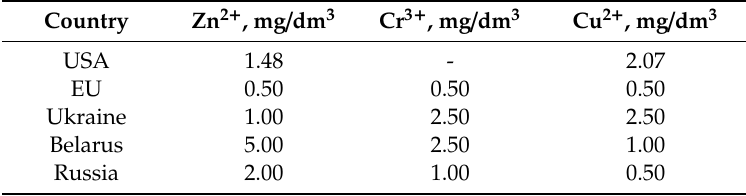
Table 10. The maximal permissible concentrations (MPC) of the studied metals in galvanic wastewaters in di ff erent